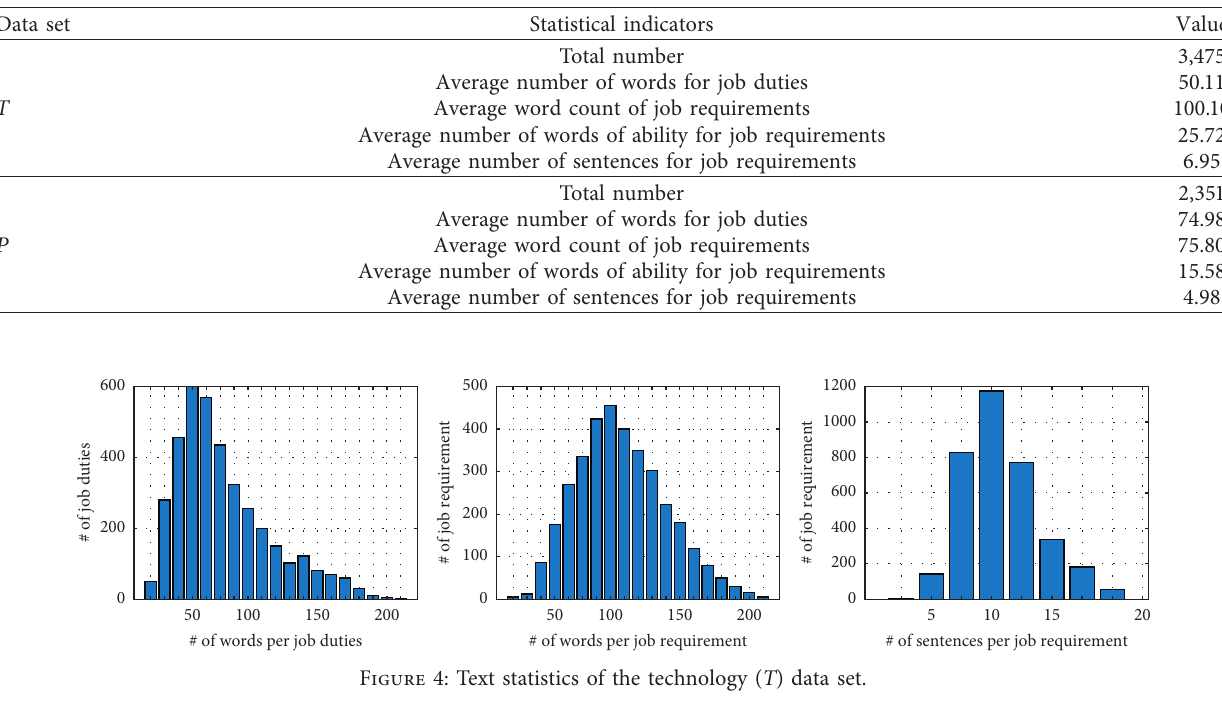
Table 1: Statistical description of T and P data sets.